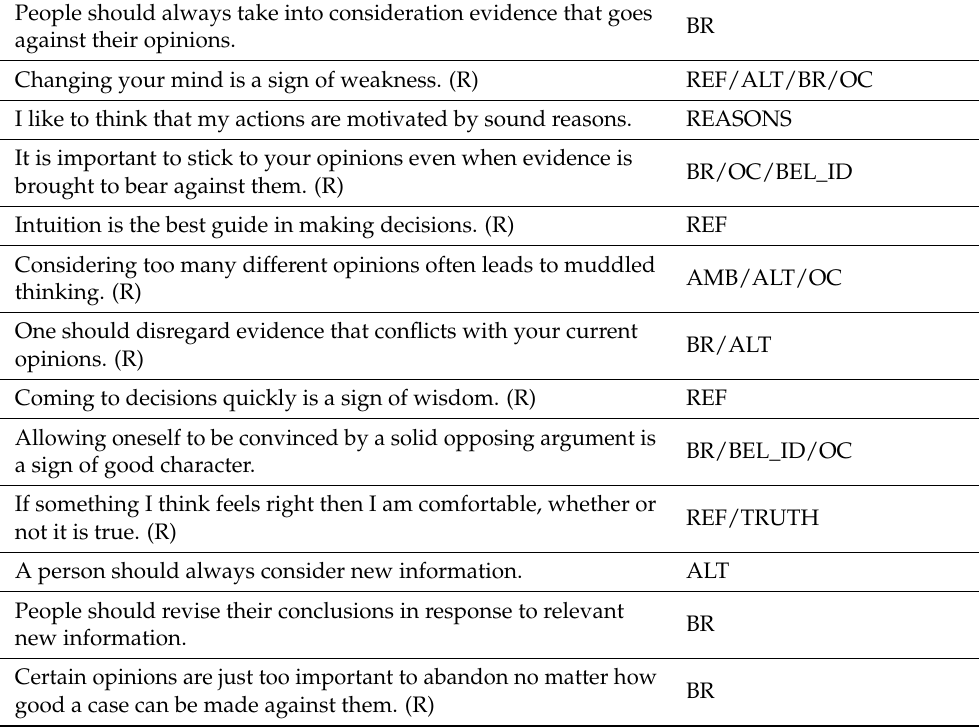
Table 1. Recommended 13-Item Actively Open-Minded Thinking Scale. People should always take into consideration evidence that goes against their